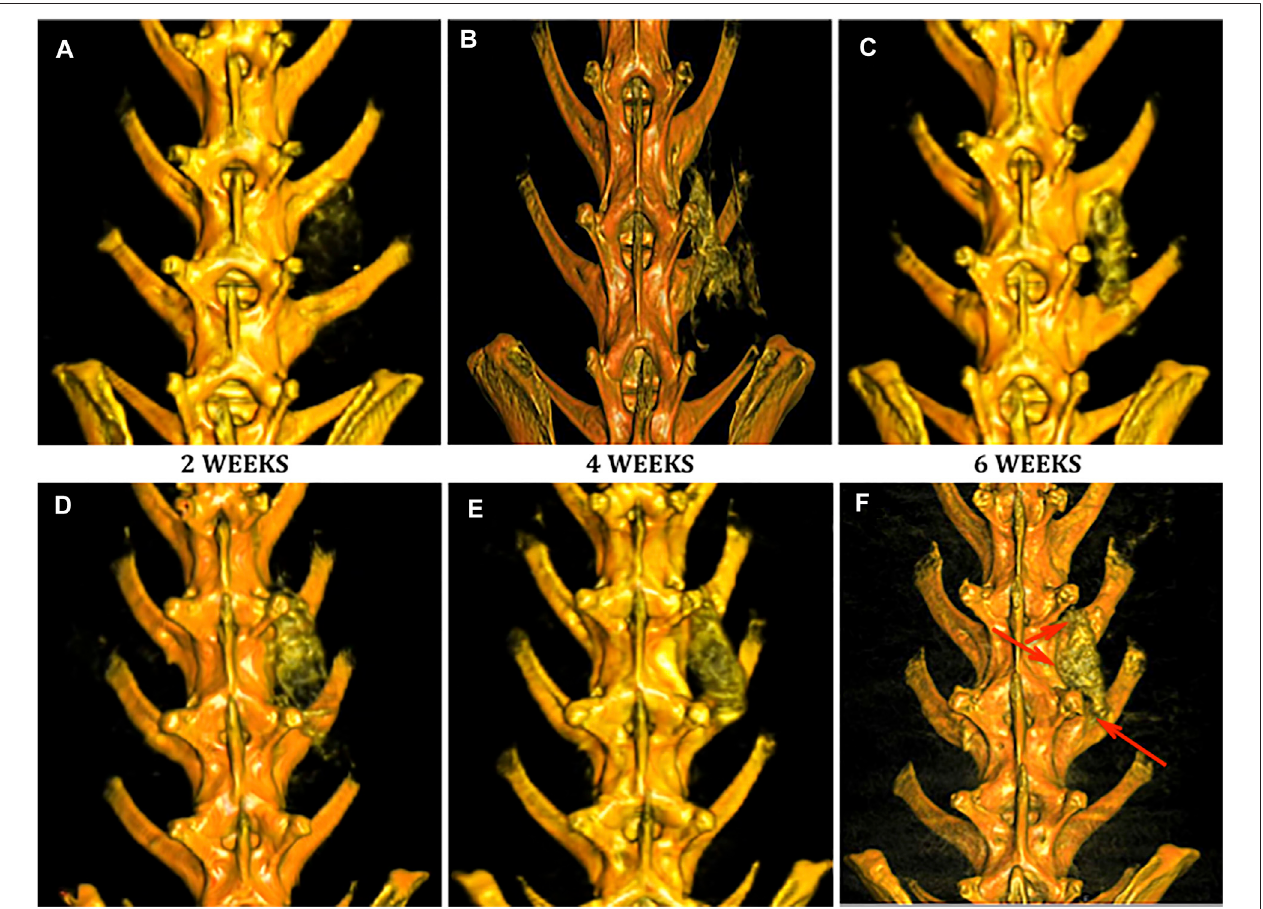
FIGURE4| EvaluationoffusionbyDynaCTwith3Dreconstruction.Representative3DreconstructionsofspinalDynaCTareshownat2,4,and6 weeksforGroup 1 nanocomposite scaffold alone (A – C) and Group 2 PRP-treated (D – F) . Areas of increased bone growth and fusion were seen at 6 weeks most prominently in Group 2 specimens